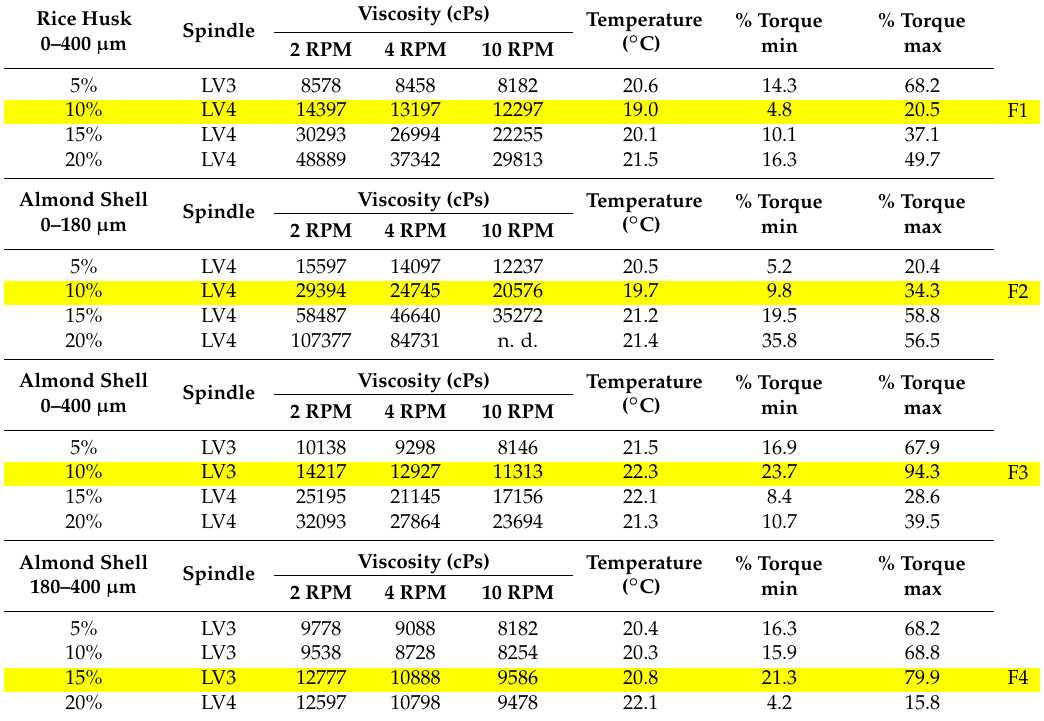
Table 1. Viscosity measurements (at a temperature of 21 ± 2 ◦ C) for different fillers and amounts.